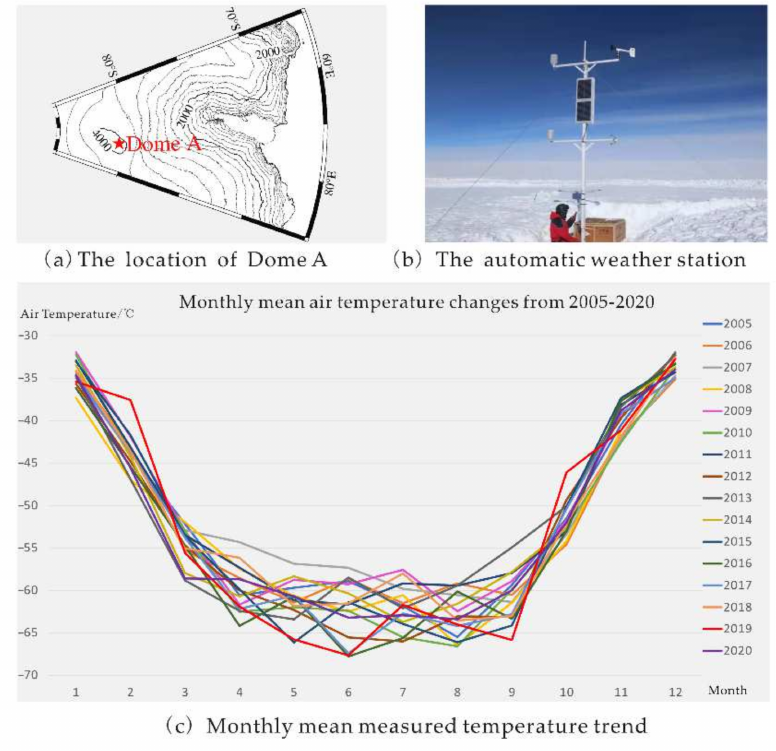
Figure 1. The location of Dome A and monthly mean measured temperature